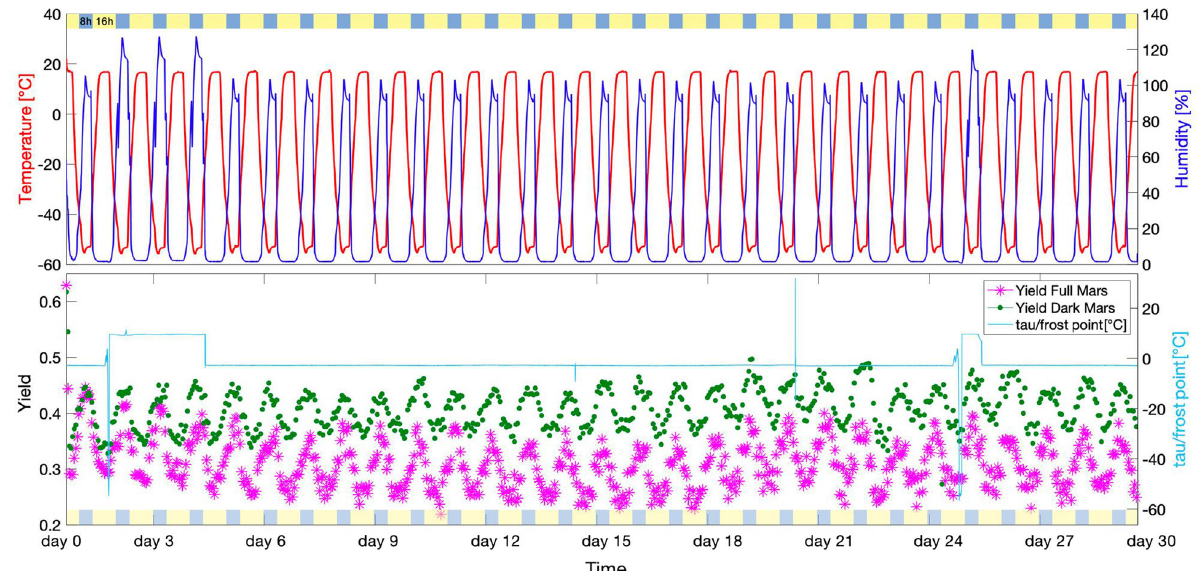
Figure 4. Above, temperature (red line) and humidity (blue line) day-night cycles as performed in the PASLAB at DLR Berlin. The light-blue/yellow stripe represents the day and night photoperiod related to the UV lamp on/ off. Below, the cyan line represents the gas mixture humidity frost-point. The magenta stars represent the Yield values of Full Mars FM samples and the green dots represent the Yield values of Dark Mars DM samples. See Table S1 for ANOVA